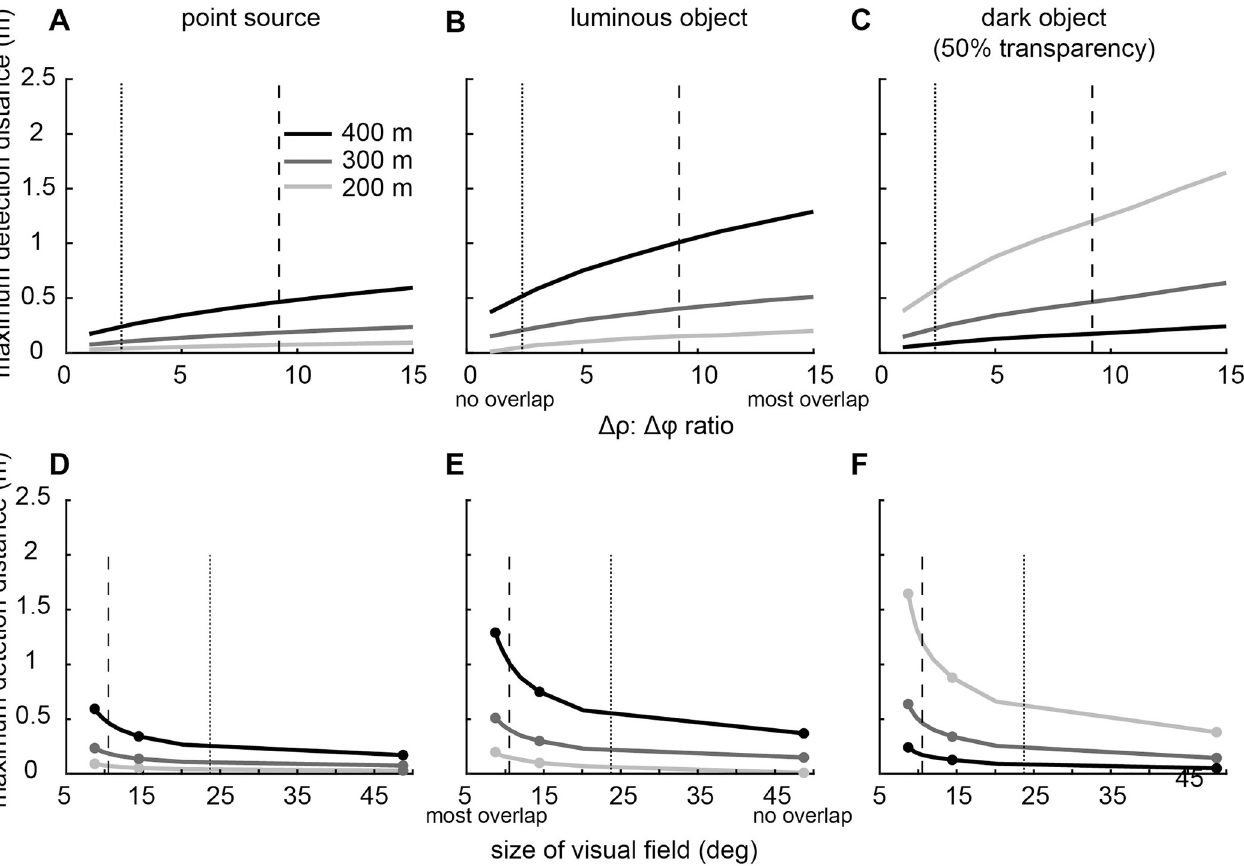
Fig 7. Effect of overlap of ommatidial receptive fields on detection distances and the size of visual field. (A-C) Increasing overlap always improved maximum detection distance for all targets. (D-E) However, there is a clear trade-off between detection distance and the size of field of view due to ommatidial overlap. Columns show the model results for the detection of a point source (A, D), an extended luminous object (B, E), and an extended dark object (C, F). The number of ommatidia summating in a single channel was calculated as a function of Δ ρ : Δ ϕ ratio [10]. For overlaps greater than 16, there are not enough ommatidia within an eye of Phronima to from two distinct channel. The size of the field of view and the receptive field size of the target channel were calculated using the derivations shown in the S3 Appendix. The acceptance angle was taken from the medial eyes of Phronima , 3.9˚ (Table 2), and we varied the interommatidial angle (from 0.26 to 3.9˚) to model different Δ ρ : Δ ϕ ratios. Dotted vertical lines show the overlap measured in our Phronima specimens ( Δ ρ : Δ ϕ = 2.4) and dashed vertical lines show the overlap measured by Land [6] ( Δ ρ : Δ ϕ = 9.2). Small circles in (D-F) shows Δ ρ : Δ ϕ ratios of 1, 5 and 15.